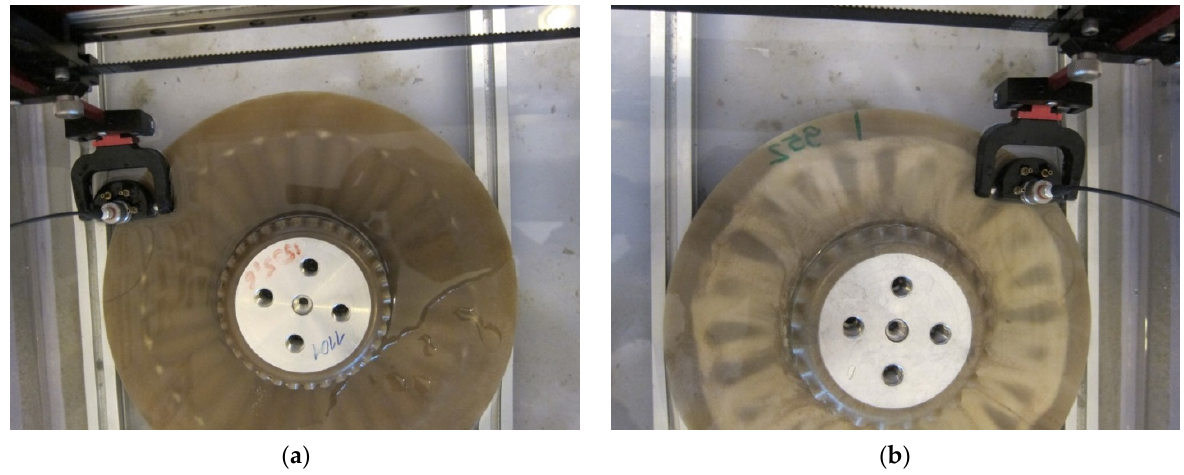
Figure 6. The testing procedure of ( a ) larger and ( b ) smaller disks using UT technique.